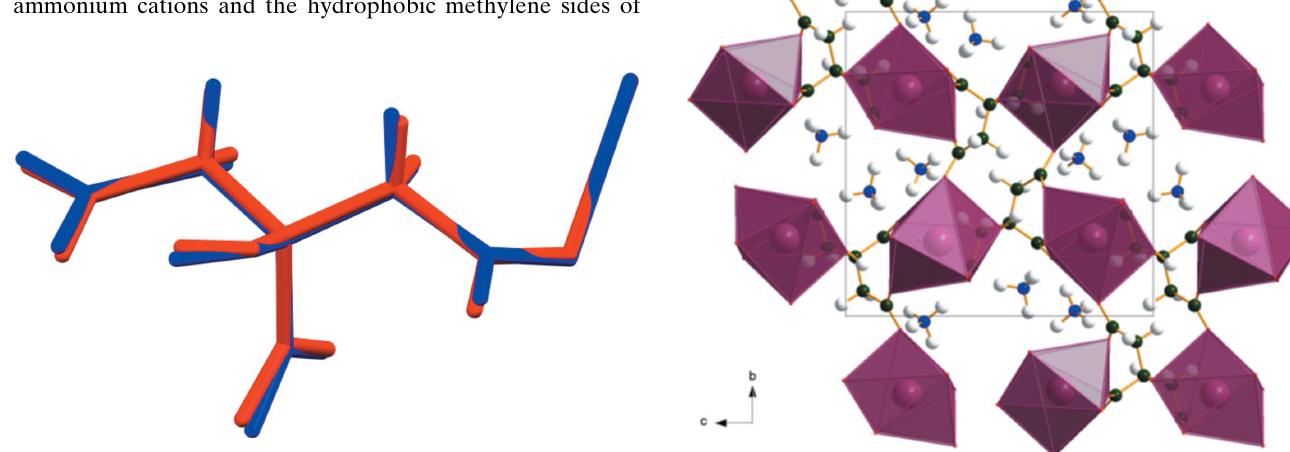
Figure 2 Comparison of the refined and optimized structures of (NH 4 ) 2 KC 6 H 5 O 7 . The refined structure is in red, and the DFT-optimized structure is in blue.